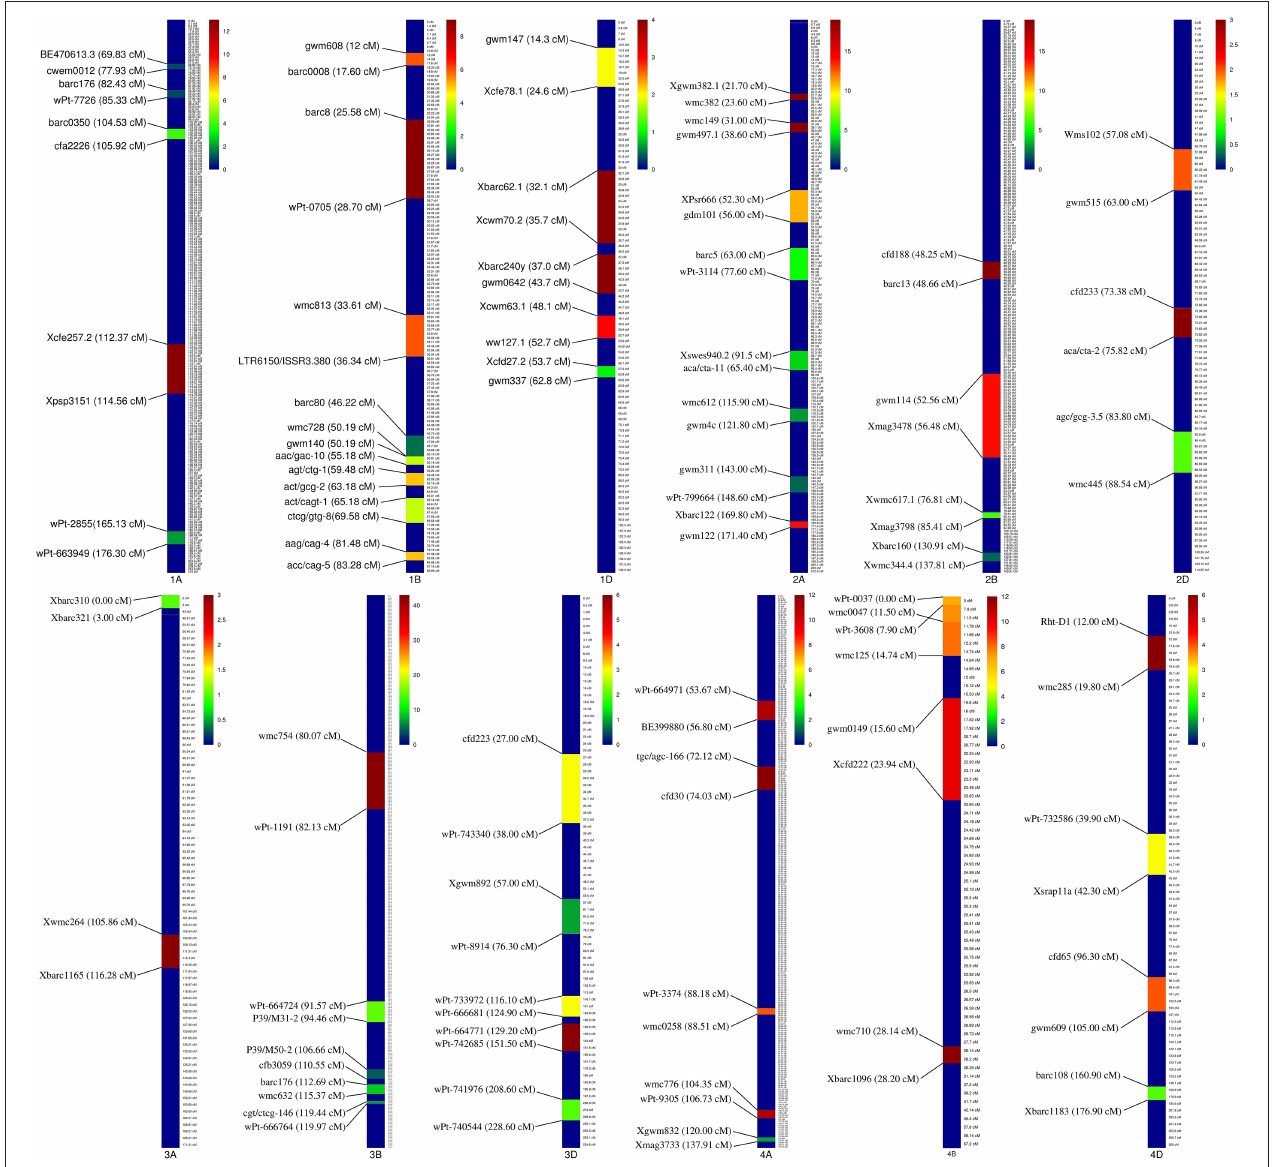
FIGURE 4 | Position of detected meta-quantitative trait loci (MQTLs) on the wheat genome associated with micronutrient content, grain quality, and quantitative traits with 95% confidence interval (CI). Each color in a different linkage group indicates the number of initial QTLs involved in each MQTL. The flanking markers for each MQTL are presented on the left side of the linkage